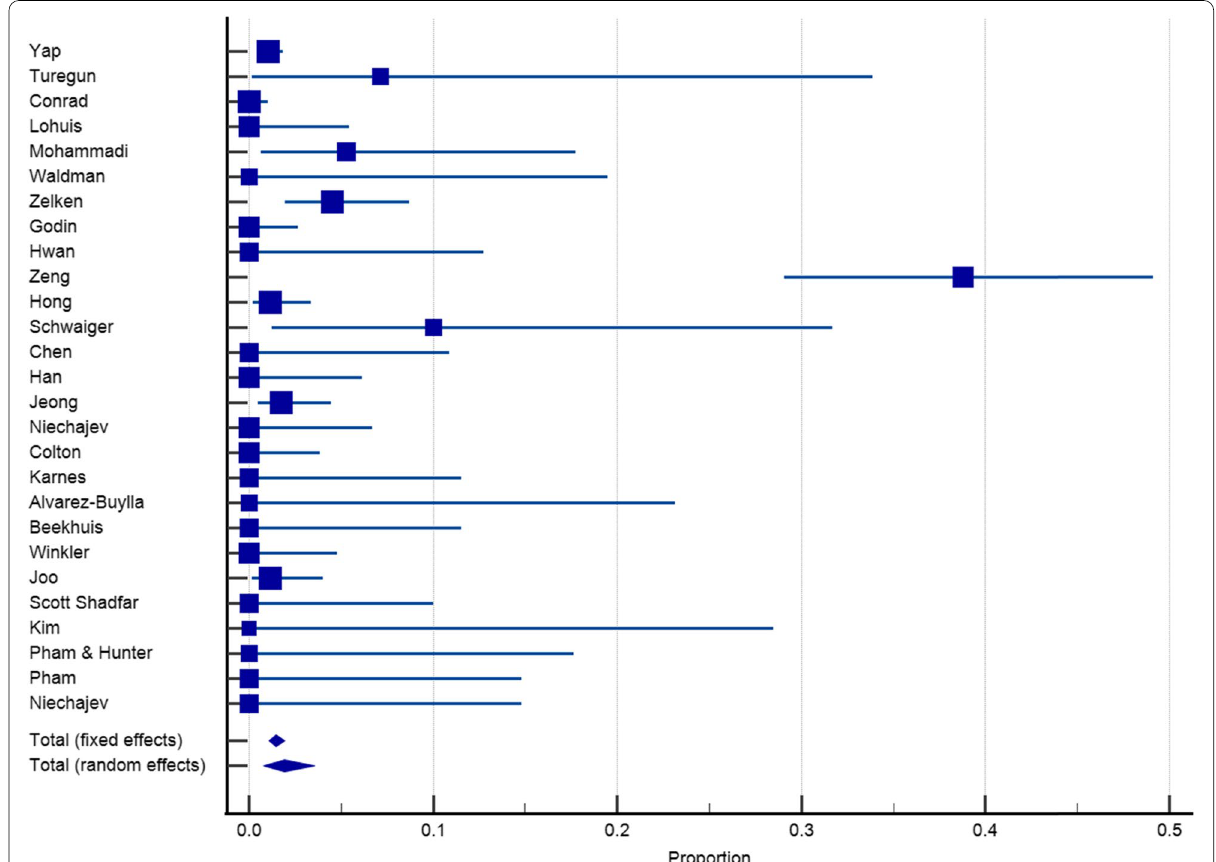
Fig. 3 Deviation rates reported for synthetic materials in both fixed and random-effects